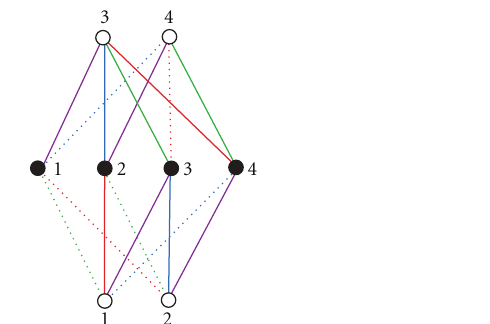
Figure 4: The shadow of the chiral multiplet, expressed as an Adinkra equivalent to the transformation rules (cid:4) C.3 (cid:5) .